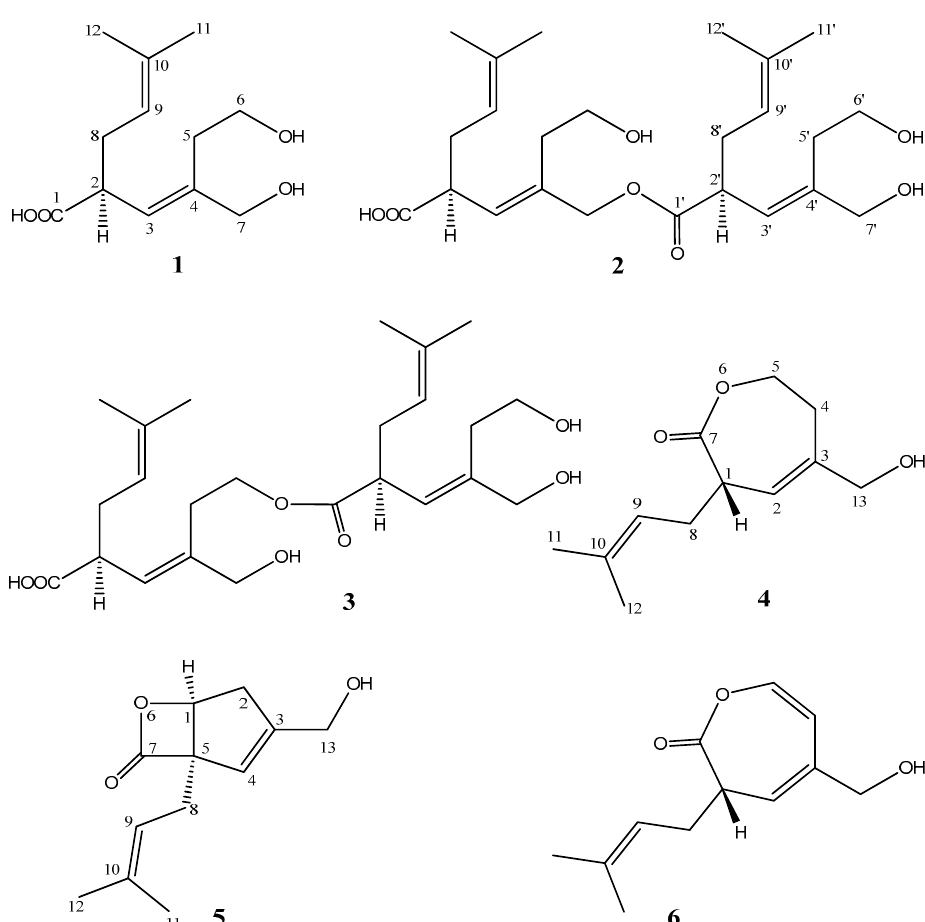
Figure 1. Structures of sterepinic acids A–C ( 1 – 3 ), dihydro-1,5-secovibralactone ( 4 ), and known compounds 5 and 6 .